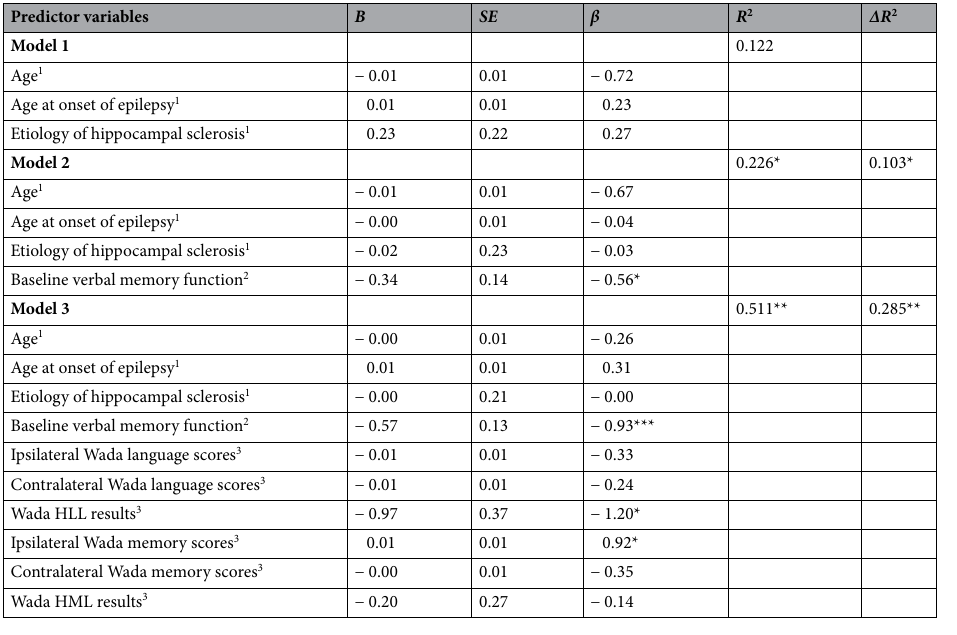
Table 5. Results of the hierarchical linear regression analysis for the prediction of postsurgical change in verbal memory function. Predictor variables entered the regression models in the first 1 , second 2 , and third 3 block. B , unstandardized coefficient; SE , standard error; β , standardized coefficient; HLL, hemispheric language lateralization; HML, hemispheric memory lateralization, * p < .05; ** p < .01; *** p < .001. Etiology of hippocampal sclerosis categorized as 1 = present; 0 = absent. Wada HLL results categorized as 1 = surgery within the language-dominant hemisphere; 0 = surgery within the non-dominant hemisphere. Wada HML results categorized as 1 = surgery within the memory-dominant hemisphere; 0 = surgery within the non-dominant